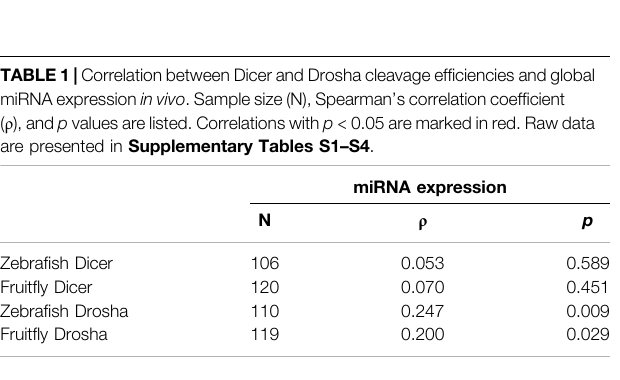
FIGURE 3 | Representative processing reactions by zebra fi sh and fruit fl y Dicer and Drosha. (A) Cleavage of 32 P-labeled dre-pre-miRNAs by zebra fi sh Dicer. miRNAsubstratesareindicatedontopofthegelimage, DNAmarkersshownontheleft,andthearrowhead pointstothecleavageproduct(s). (B) Cleavageofdme-pre- miRNAs by fruit fl y Dicer. Labeling is the same as in (A) . (C) Cleavage of dre-pri-miRNAs by zebra fi sh Drosha. Arrowheads point to cleavage products. (D) Cleavage of different dme-pri-miRNAs by fruit fl y Drosha. Labeling is the same as in (C) .